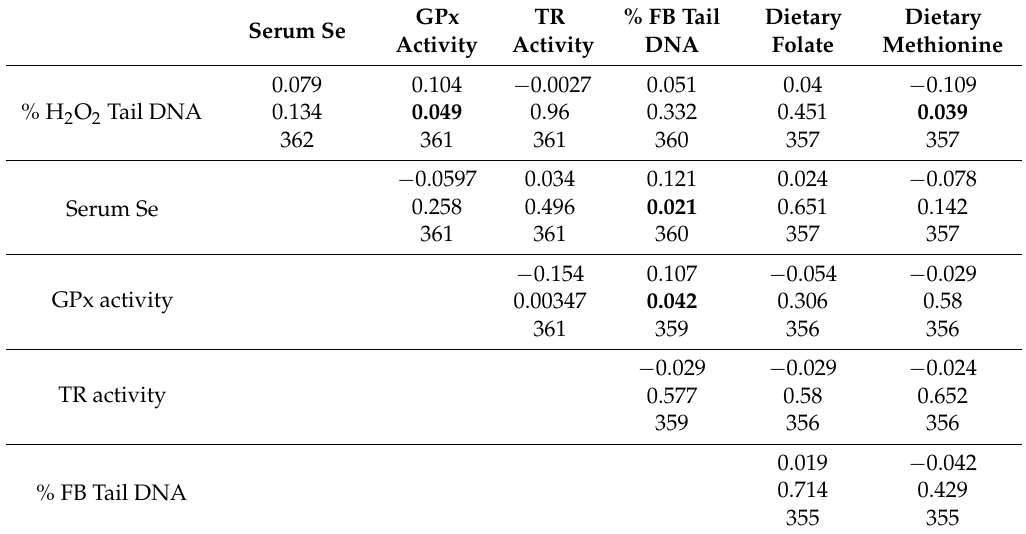
Table 6. Post-supplementation correlations between parameters assessed for complete